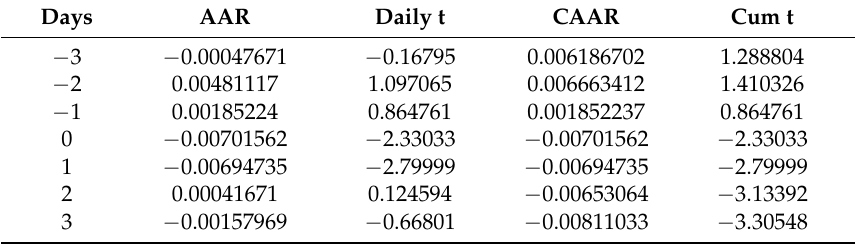
Table 7. Event study of insurance companies for the second event. Source: Authors’ work.